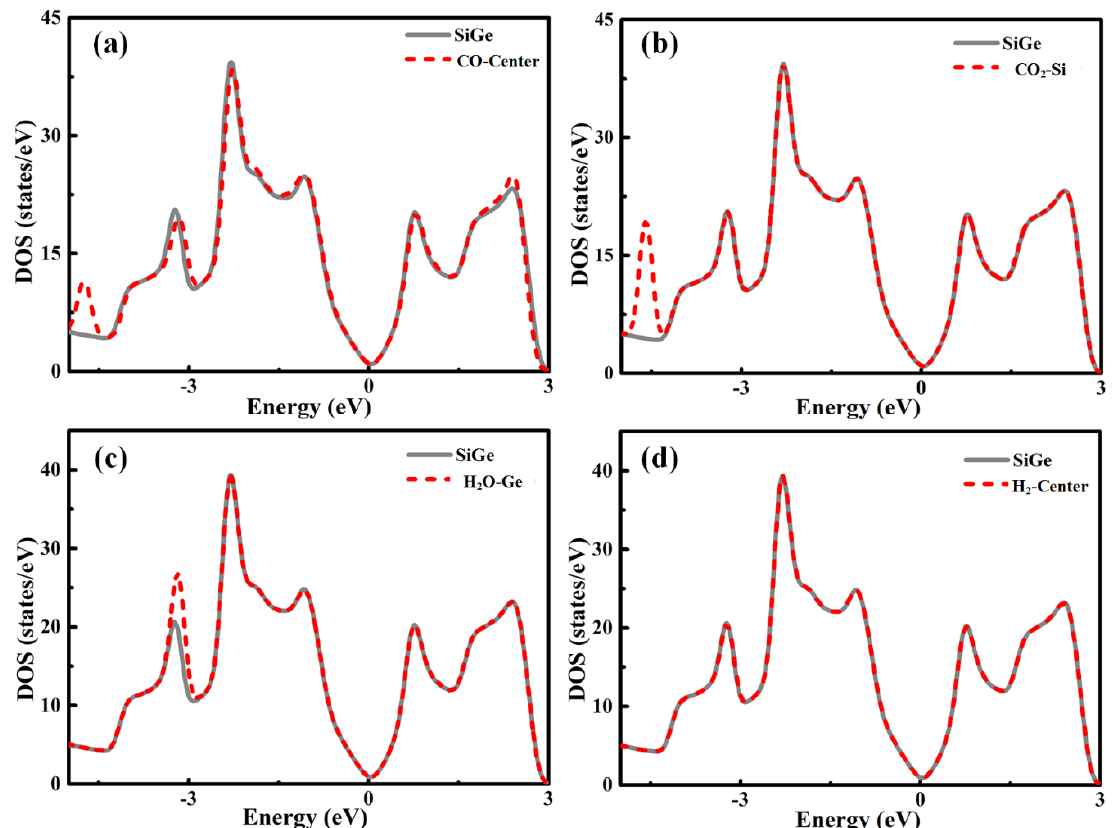
Figure 2. Total density of state for the ( a ) CO-center, ( b ) CO 2 -Si, ( c ) H 2 O-Ge, and ( d ) H 2 -center adsorption models. DOS, density of state.